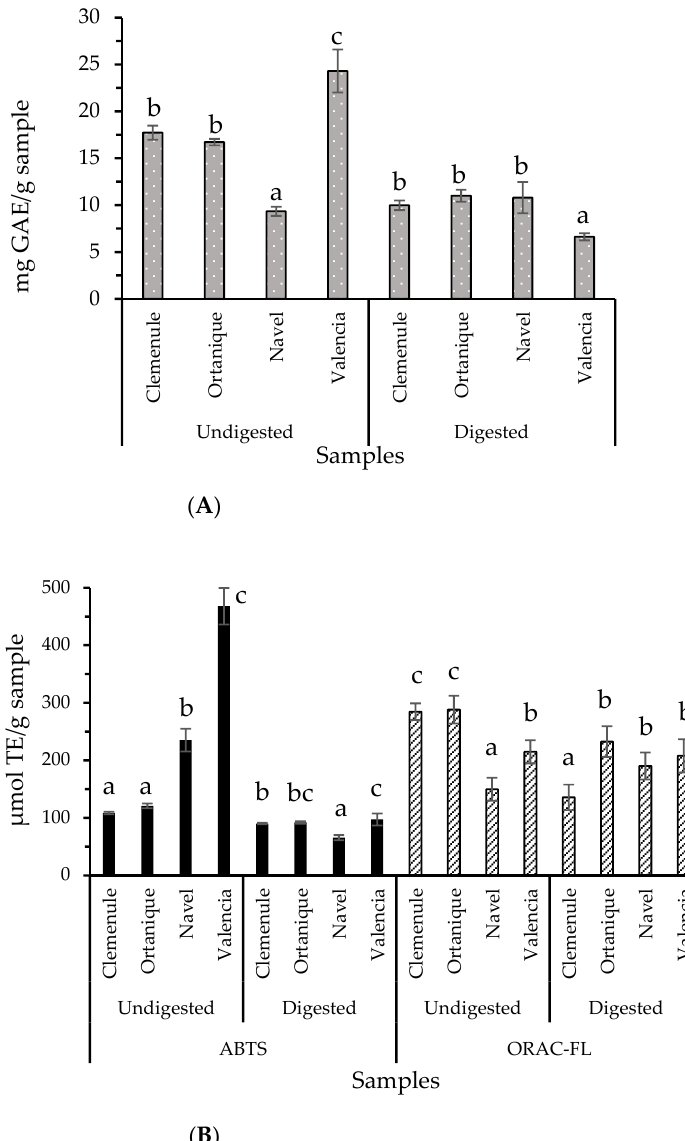
Figure 1. Antioxidants composing undigested and digested raw citrus pomaces: ( A ) Total Phenol Content (TPC). ( B ) ABTS and ORAC-FL assays. Bars and error bars represent mean values and standard deviation, respectively. Different letters (a, b and c) indicate significant differences (Tukey, p < 0.05) between values in each set of four samples where sets of samples are undigested ABTS samples, digested ABTS samples, undigested ORAC-FL samples, and digested ORAC-FL